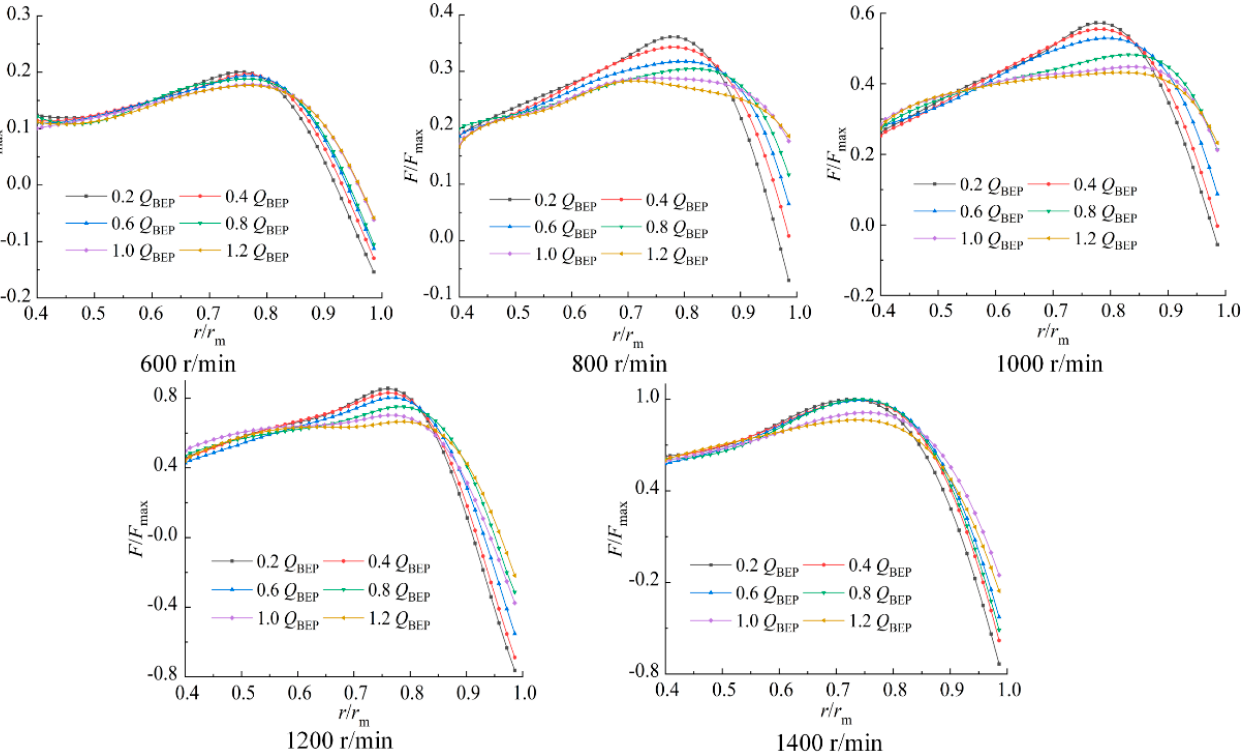
Figure 3. Blade load distribution curve under the five rotational speeds.